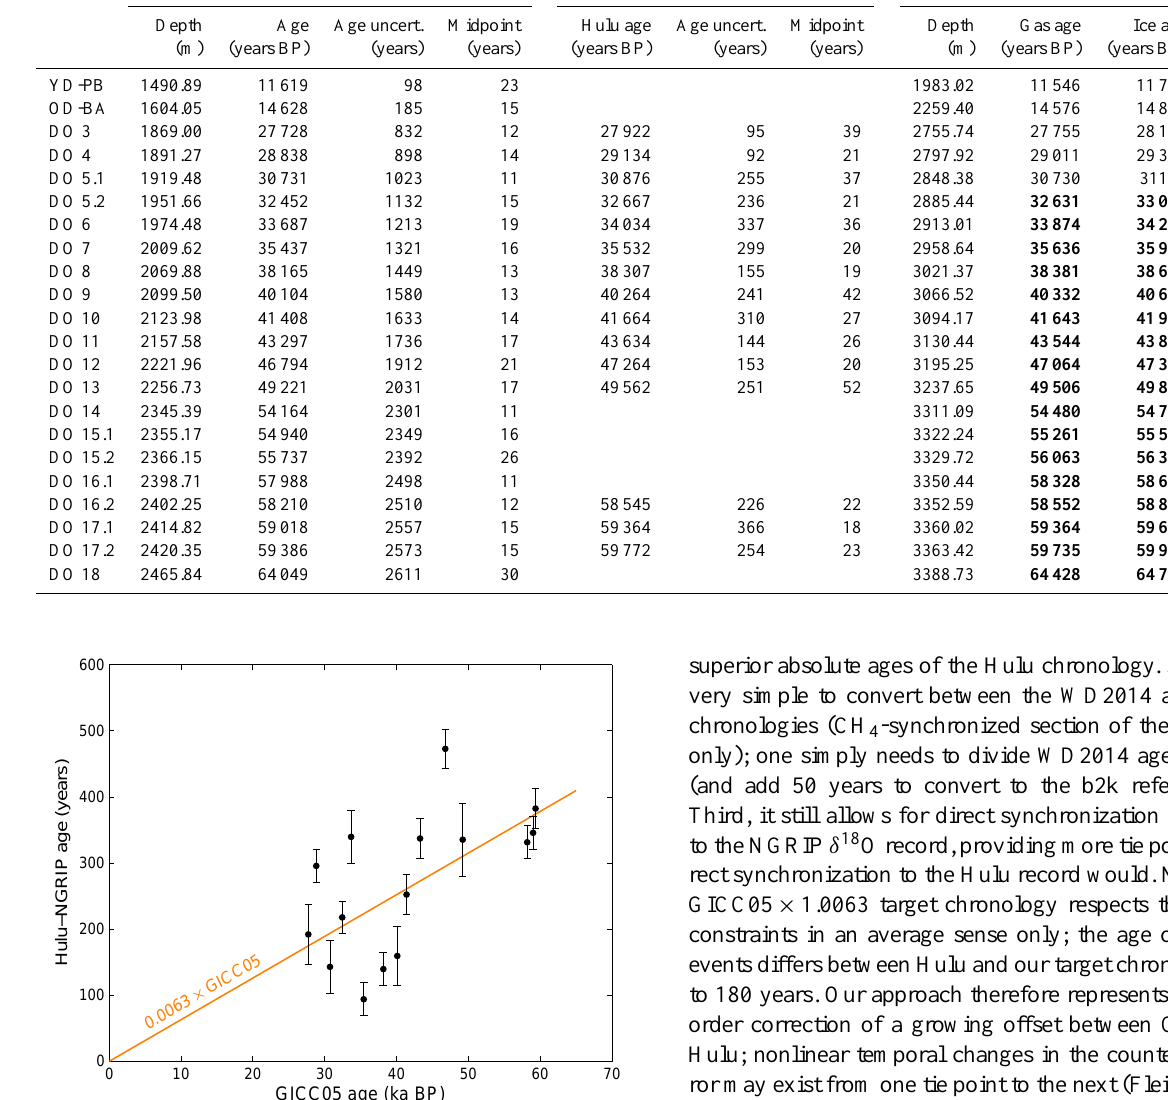
Figure 7. Hulu–NGRIP age offset at the midpoint of the DO δ 18 O transitions. The error bars denote the root sum square of the mid- point determination uncertainty in NGRIP and Hulu δ 18 O (Table 1). The GICC05 ages are placed on the BP 1950 scale rather than the b2k scale (years prior to